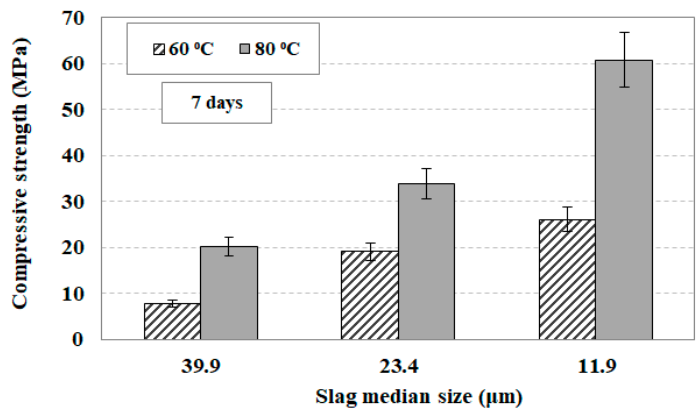
Figure 10. Effect of slag median size and curing temperature on the compressive strength of the produced alkali activated materials (AAMs). Synthesis conditions: molar ratio in the reactive paste H 2 O / Na 2 O 12.9, curing time 24 h, ageing period seven days; median sizes of 39.9, 23.4, 11.9 µ m derived after 30, 60, and 120 min of grinding, respectively. Error bars indicate the standard deviation of three measurements.